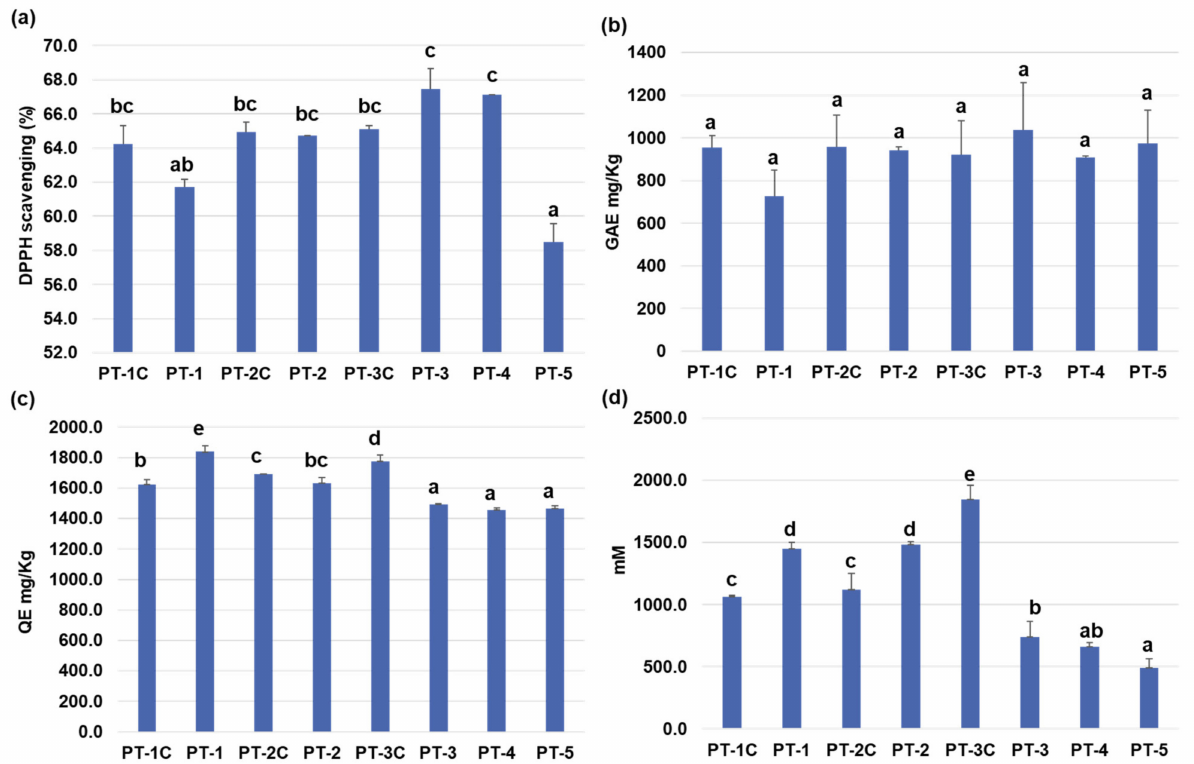
Figure 7. Antioxidant activity of leaf extracts of pepper plants grown in soil amended with SCG composts, commercial compost, and chemical fertilizer. The tests included ( a ) DPPH scavenging activity, ( b ) total phenolic content (TPC), ( c ) total flavanoid content (TFC), and ( d ) Trolox equivalent antioxidant activity (TEAC). Letters above the error bar indicates the comparison of samples using Duncan’s test.